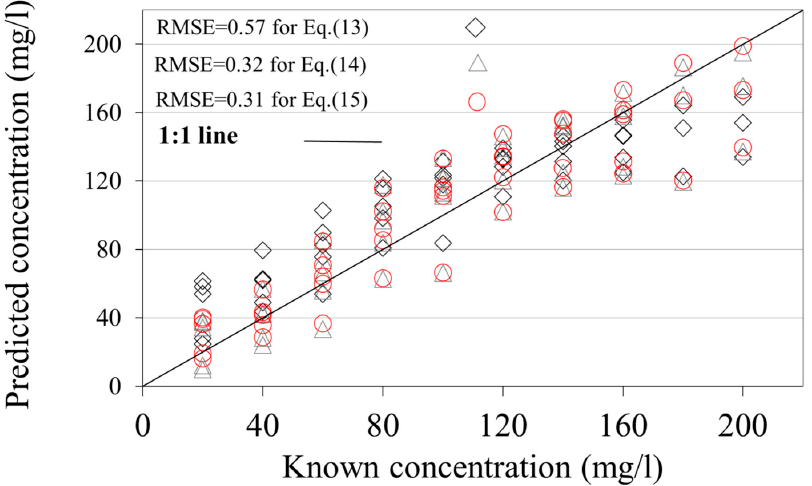
Figure 7. Predicted vs. known concentrations for mixed-sand cases, based on Equations (13)–(15). RMSE = Root-mean-square error from the 1:1 line.